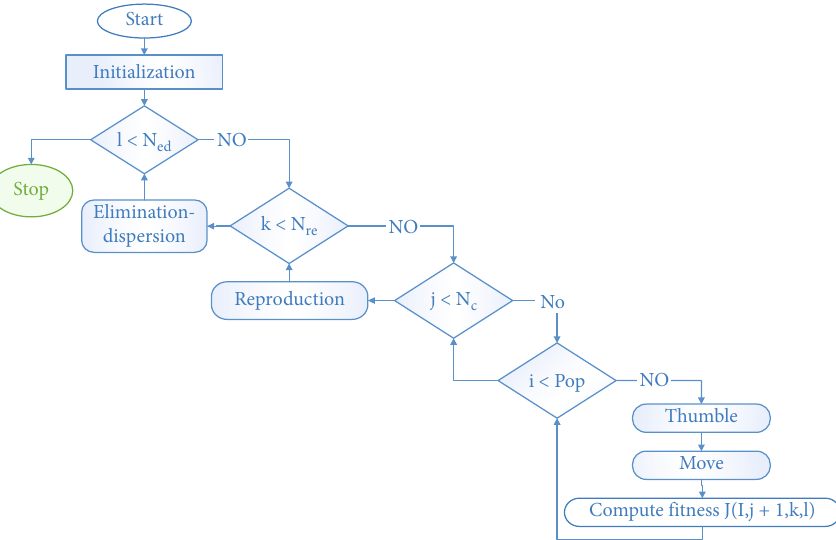
Figure 4: Schema of the BFO